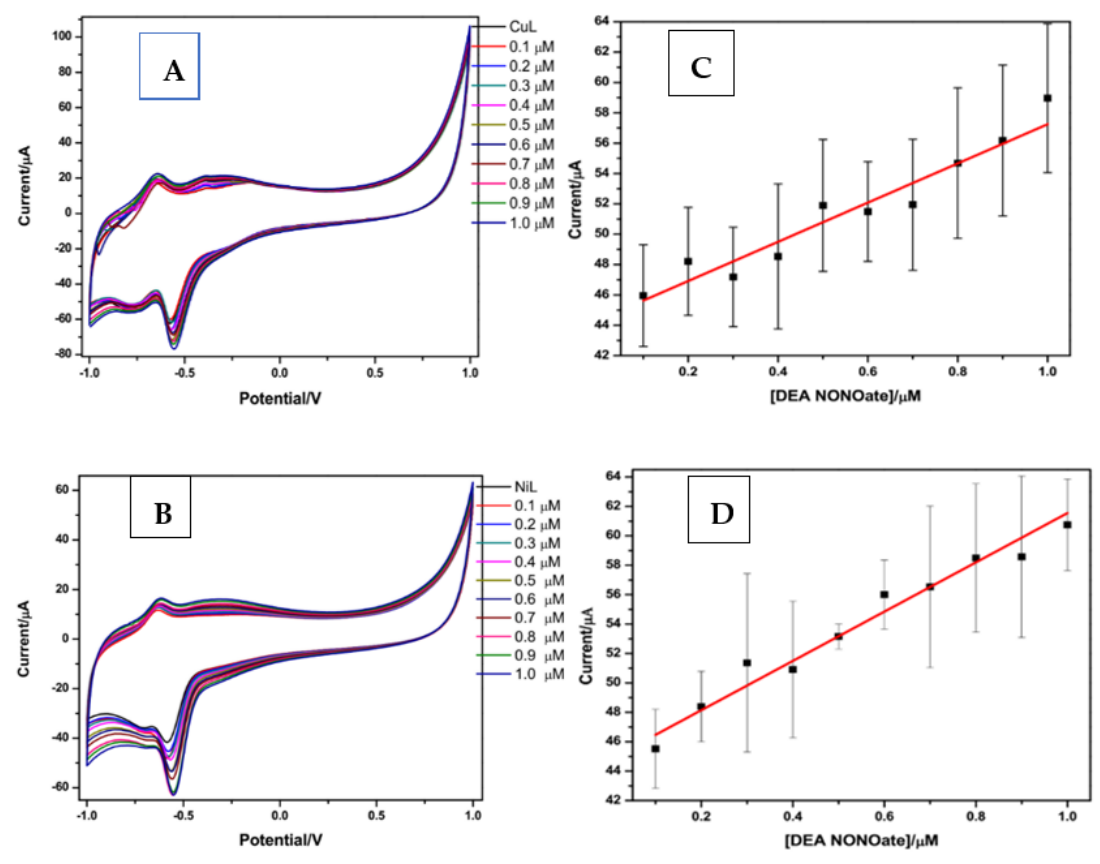
Figure 12. Cyclic voltammograms of the current response of the copper–ligand sensor to DEA NONOate dissociation ( A ); the current response of the nickel–ligand sensor to DEA NONOate dissociation ( B ) both in 0.1 M PBS (pH = 7.2) at a scan rate of 50 mV/s for successive independent concentration increase (0.1, 0.2, 0.3…1 µM). Calibration curves of the average current responses data of